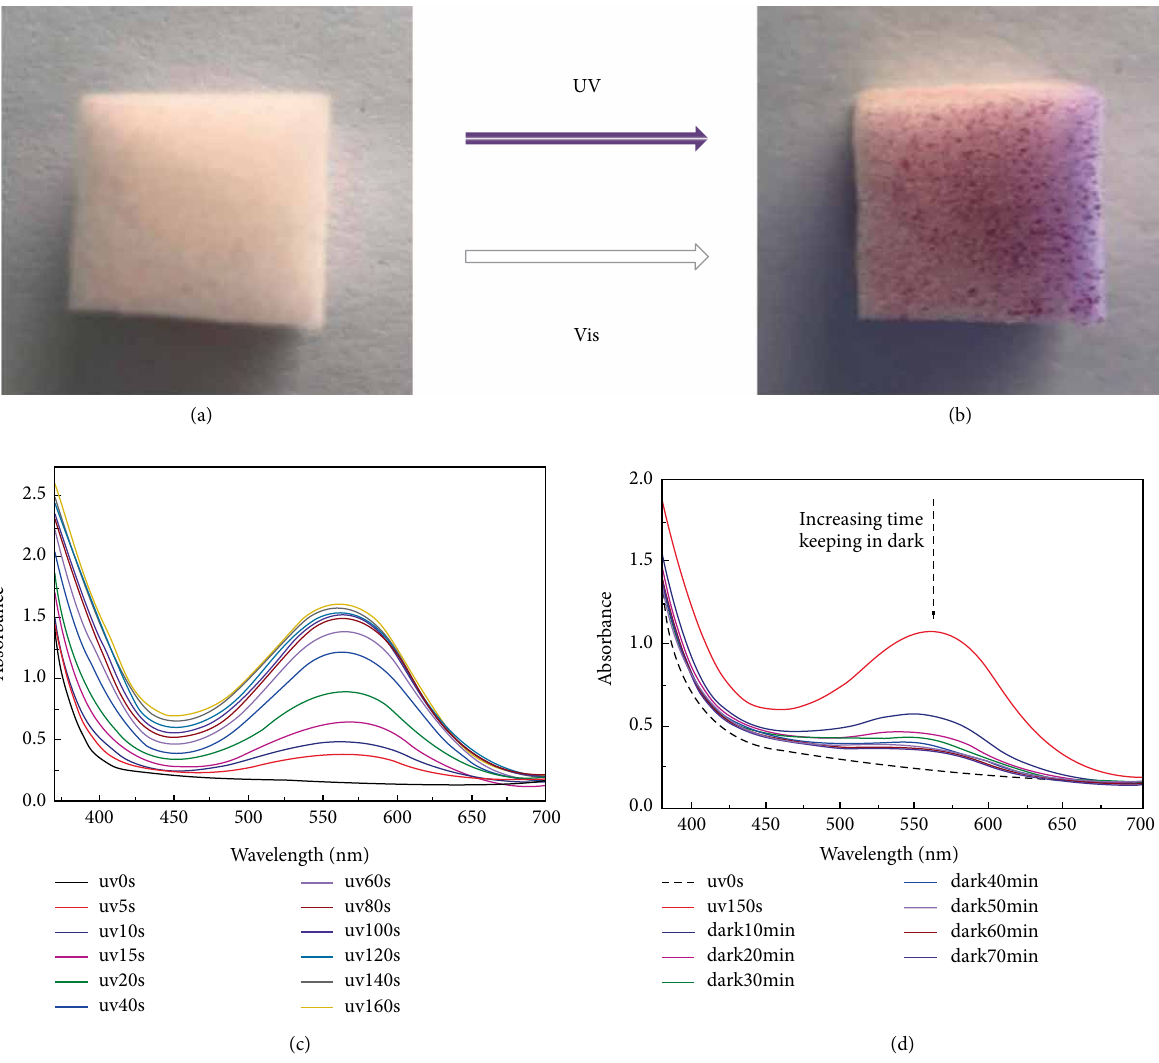
Figure 4: (a, b) Photochromic coloration of PDMS-SP modified melamine sponge under UV irradiation, (c) absorbance curves of cross-linked PDMS/SPMA after UV irradiation, (d) absorbance changes with exposure time under UV/vis